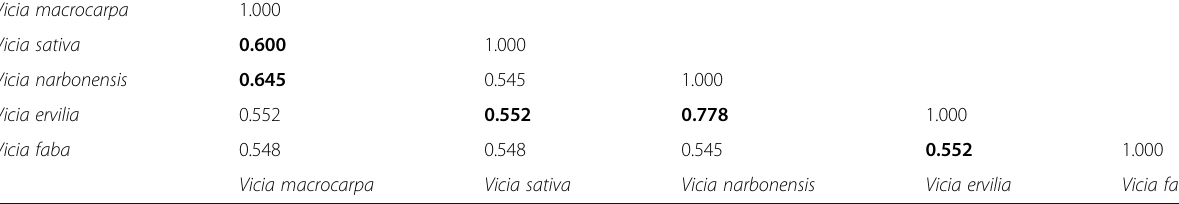
Table 2 The level of similarities among Vicia species, produced by Jaccard ̍ ’ s coefficient, based on water-soluble proteins Vicia